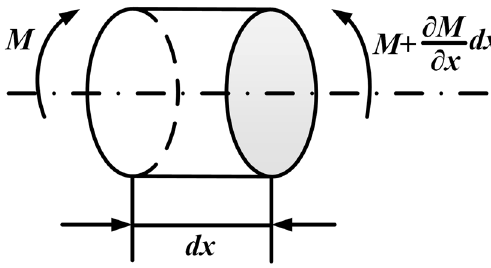
Figure 2. Micro-segment without concentrated